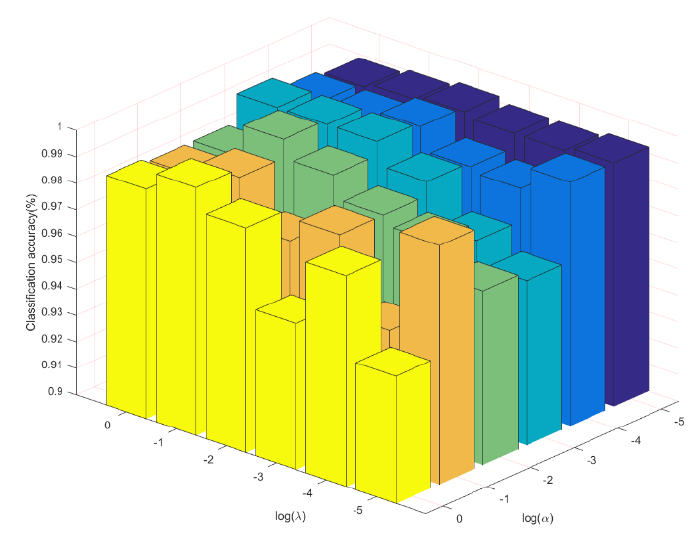
Figure 4. Effects of λ and α parameter selection on classification accuracy.